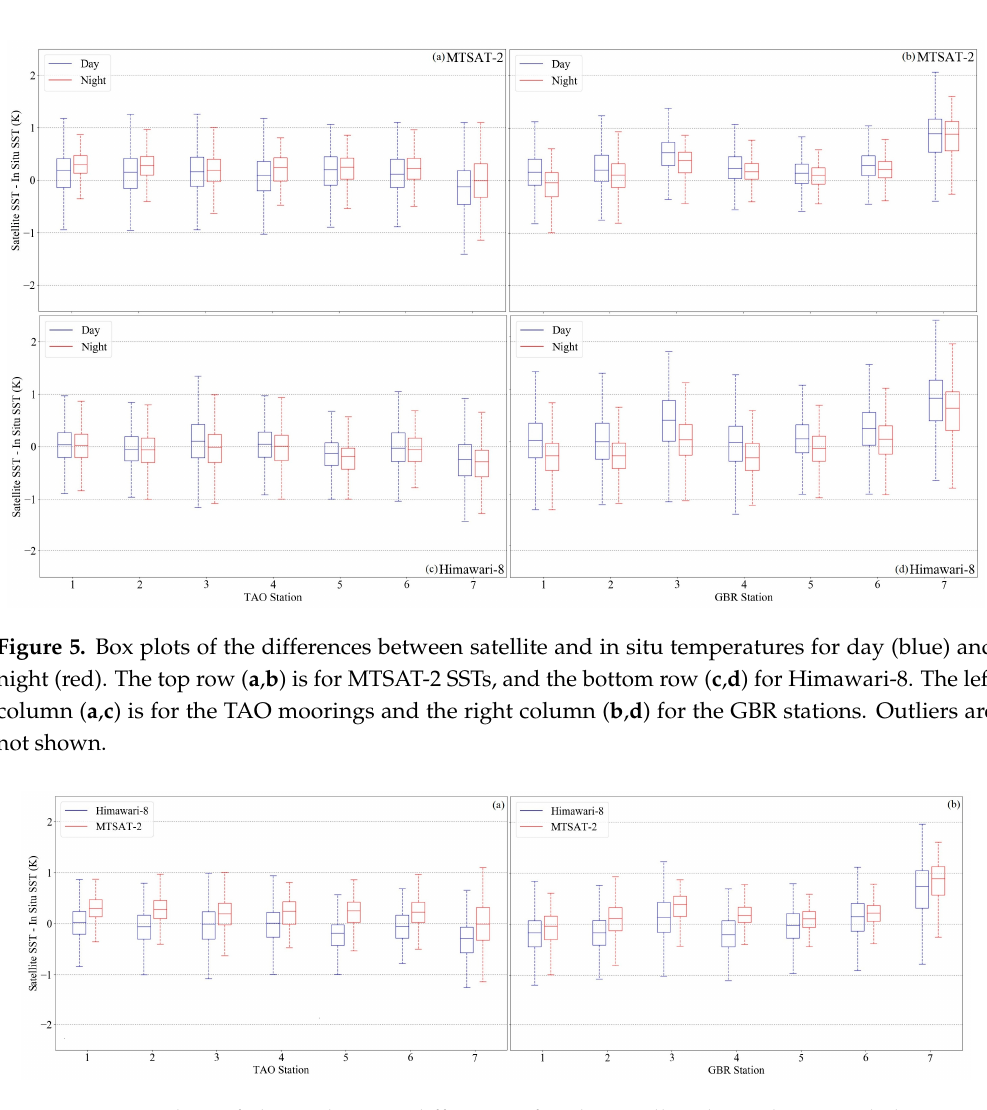
Figure 6. Box plots of the night-time differences for the satellite-derived SST and the in situ temperatures for Himarari-8 (blue) and MTSAT-2 (red). TAO moorings are at left ( a ); GBR stations at right ( b ). Outliers are not plotted.